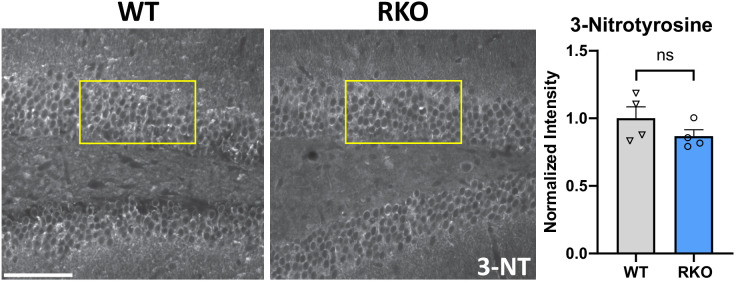
No change in dentate gyrus neuronal 3-nitrotyrosine in RKO mice.Representative images of 3-nitrotyrosine staining in DG of WT and RKO mice. Yellow boxes indicate the typical area of intensity quantification. N = 4 mice/genotype, two sections/mouse averaged. Scale bar = 50 µm. p>0.01 by two-tailed T-test.